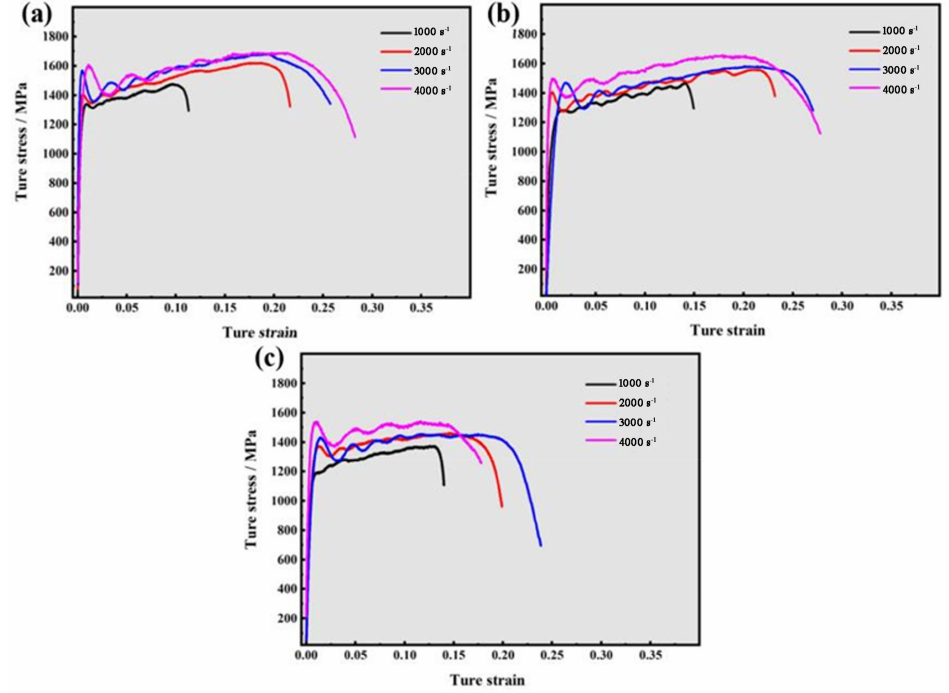
Figure 4. True stress–strain curves of Ti-6321 alloy with different microstructures: ( a ) EM; ( b ) DM; ( c )